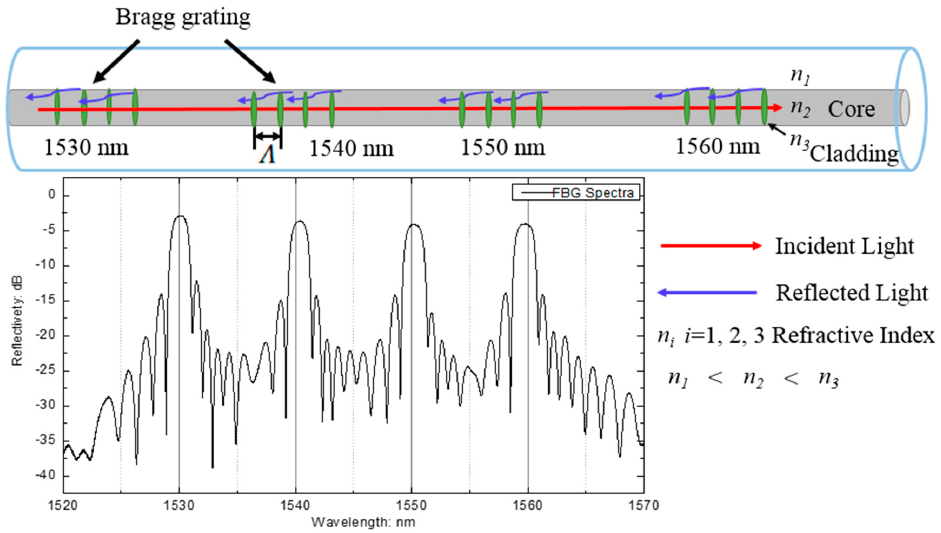
Figure 3. Optical reflection spectrum of the wavelength-division multiplexing techniques.